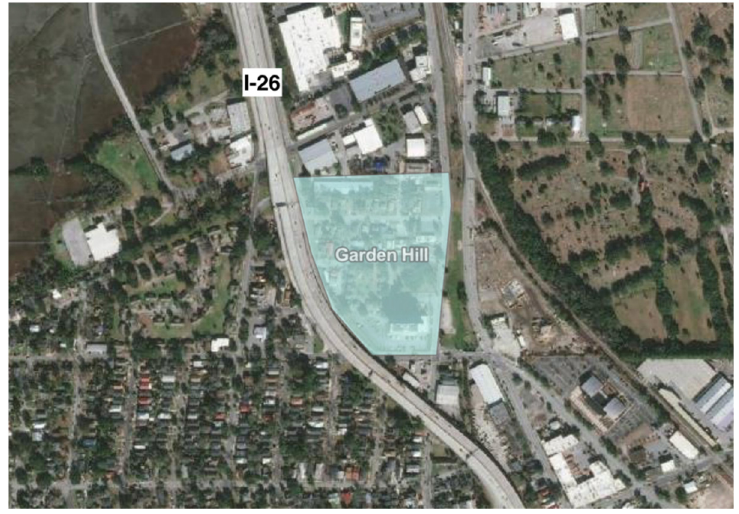
Figure 11. Aerial imagery showing highway infrastructure surrounding the Garden Hill